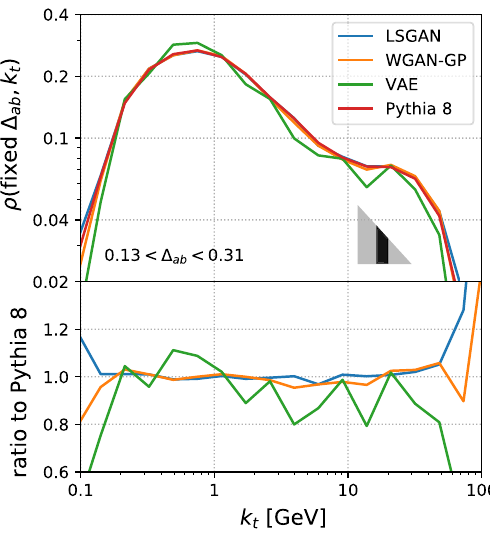
Fig. 8 Slice of the Lund plane along Δ ab with 7 . 4 GeV < k t < 25 . 8 GeV